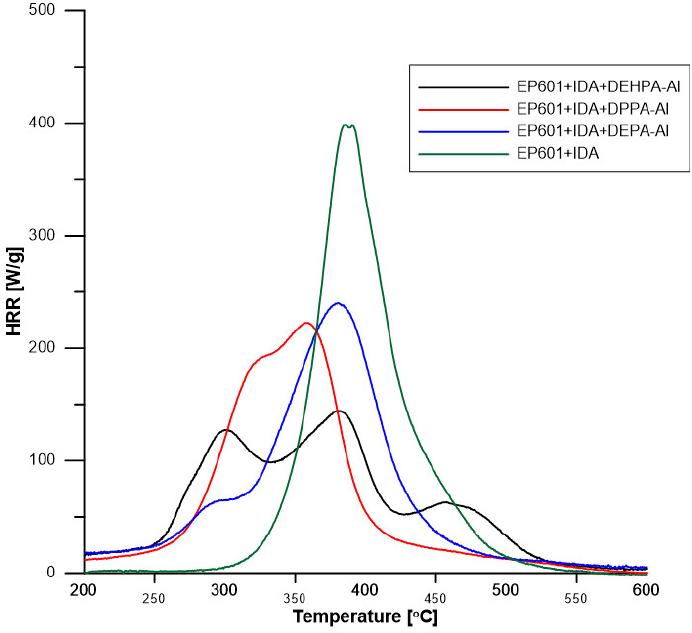
Figure 9. PCFC graphs for obtained composites.